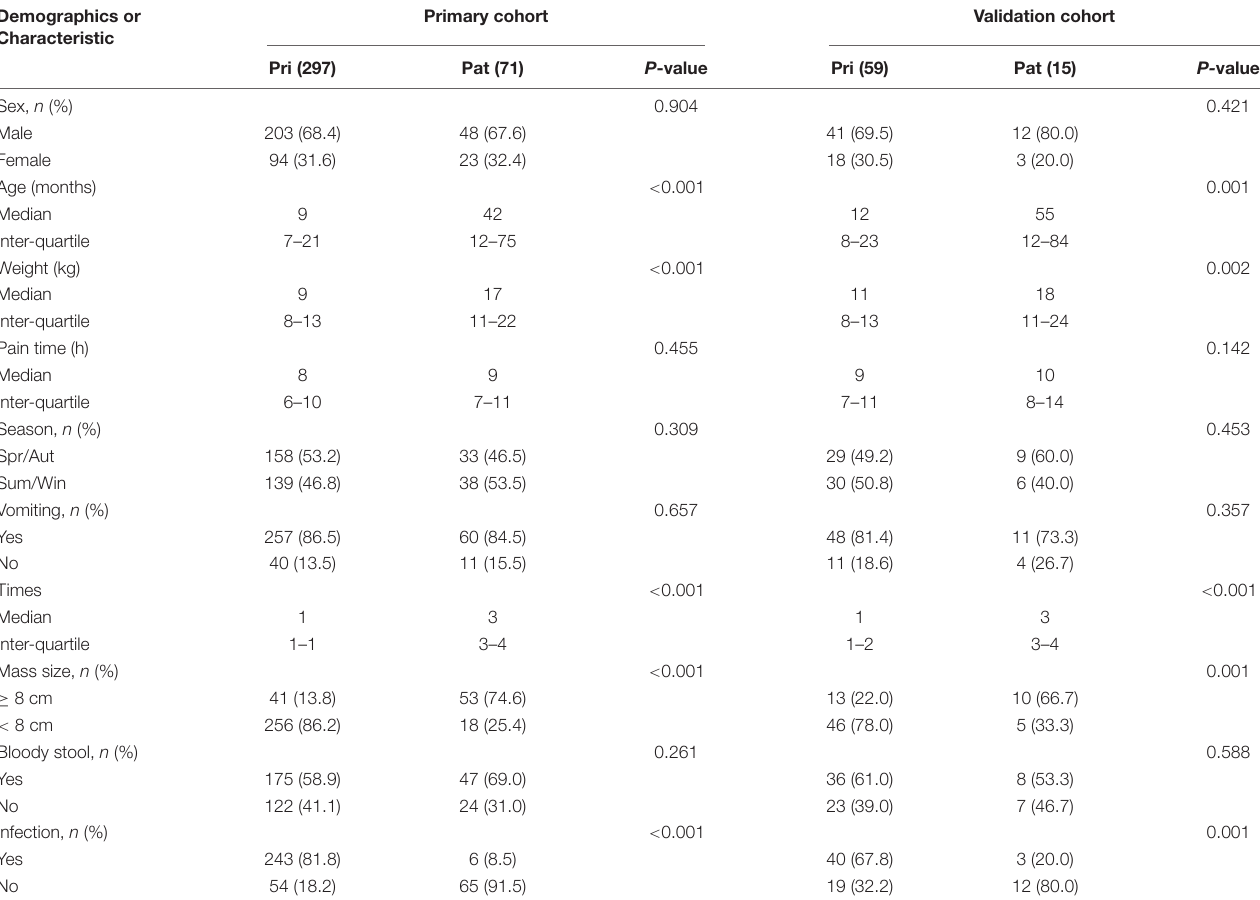
TABLE 2 | Demographics and clinicopathologic characteristics of children in the primary and validation cohorts. Demographics or Characteristic